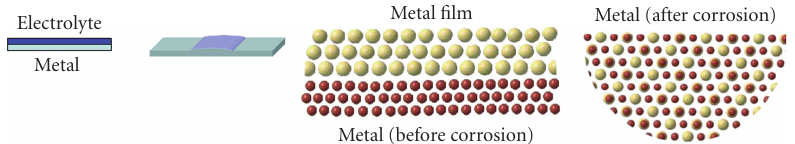
Figure 1: Schematic drawing of corrosion metal degradation under an electrolyte solution. Atoms in metal films are shown in yellow and metal atoms in red. If we assume that ε f 0 = ε M 0 , then the energy to move atom in metal film is to be same as energy needing to move atom in metal. The lateral force to move atom for Cu was measured F = 17 ± 3 pN [17] and x = 300pm, then approximate energy per atom was measured E = F · x = 5 . 1 · 10 − 22 J; recalculating it per mol of atom we will have ε f 0 = ε M 0 ≈ 3 · 10 2 J · (mol) − 1 . ε f 0 = ε M 0 ≈ 5 . 1 · 10 − 22 J (a) per atom; and ε f 0 = ε M 0 ≈ 3 · 10 2 J · (mol) − 1 (b) per mol number of atoms. We use (1) as an estimation as we are calculating everything on number of atoms or on per